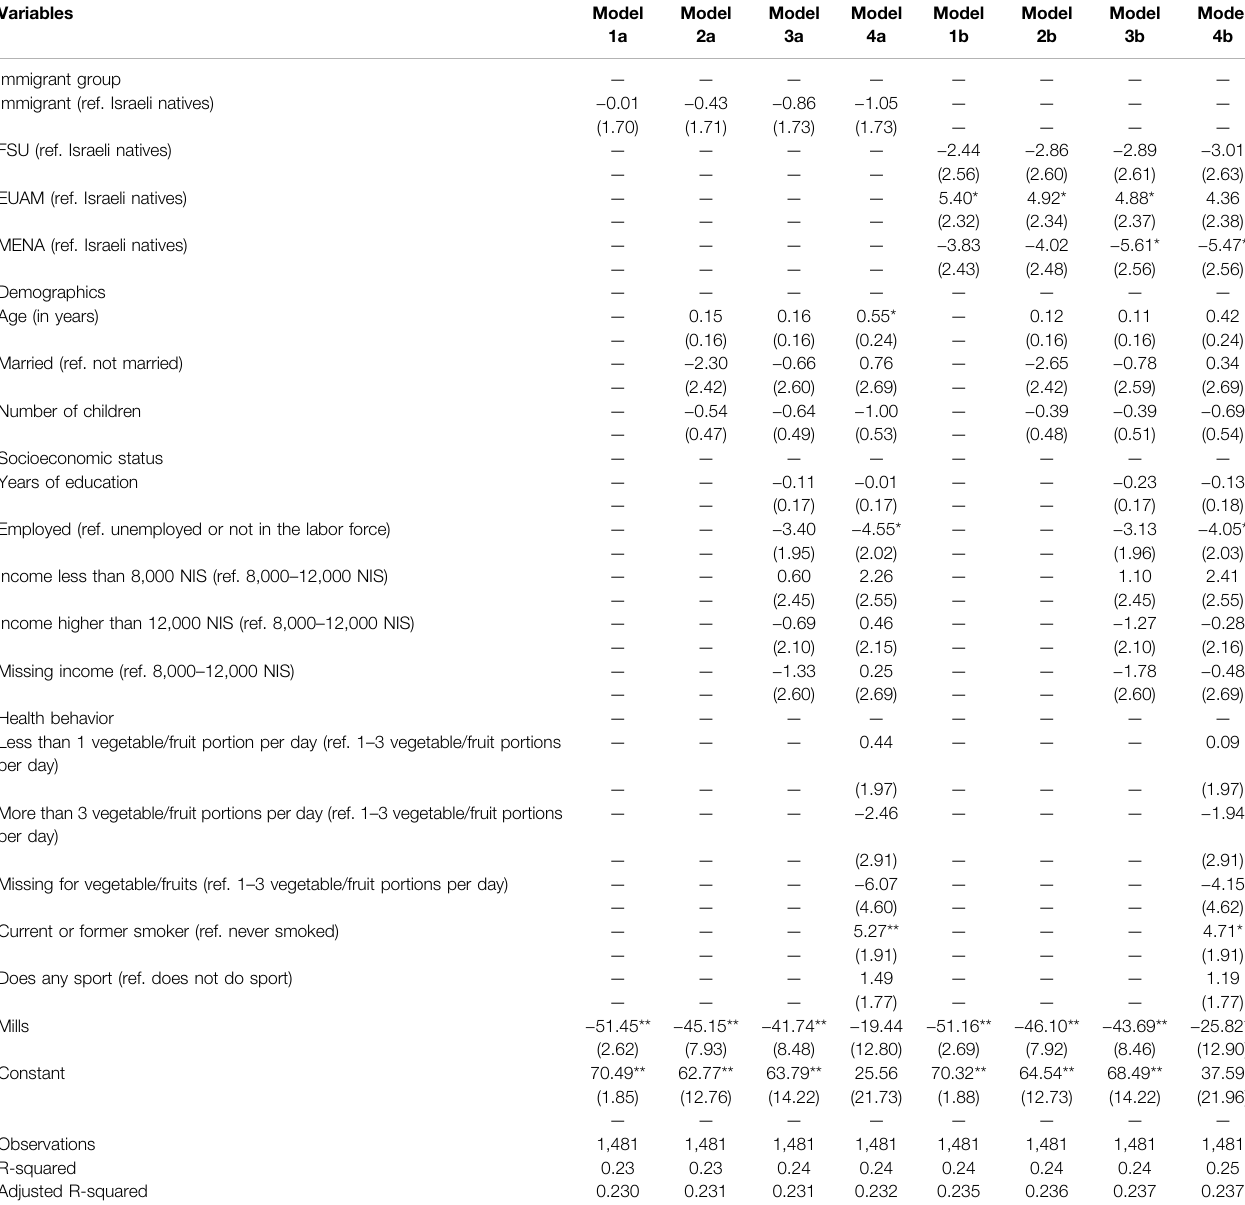
TABLE 2 | Coef fi cients (standard errors) of OLS regression equations predicting severity illness index, Men.